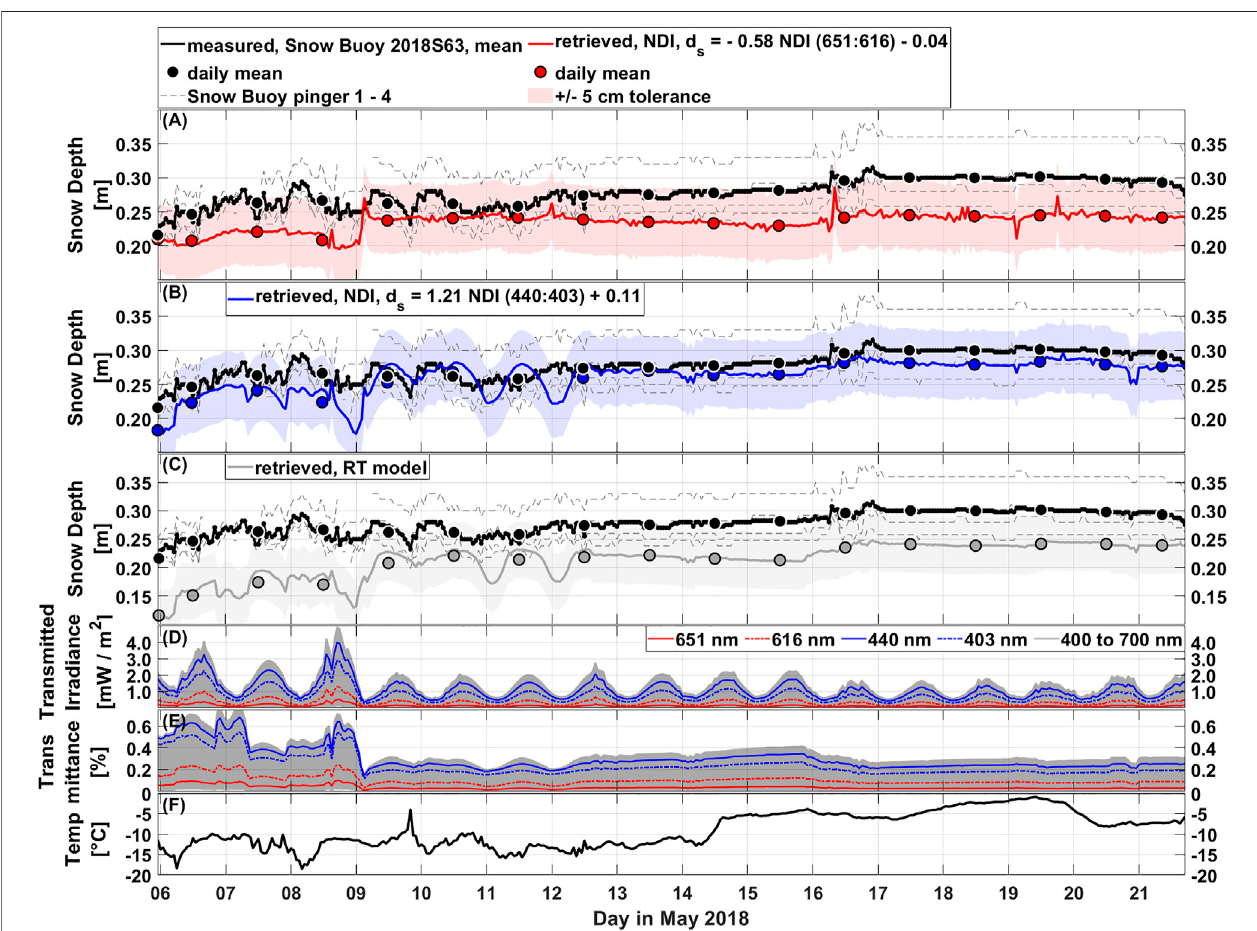
FIGURE7|(A – C) HourlymeansnowdepthsmeasuredbytheSnowBuoy2018S63asobtainedonFYIduringMAPLI18(solidblack).Variationsinthesnowdepth of the four individual ultrasonic snow pingers are indicated by the respective grey dashed lines. The snow depths retrieved using the NDI method with the wavelength pairs651:616 nm[ (A) ,red]and440:403 nm[ (B) ,blue]areoverlaid.TheNDIswerecalculatedfromthe2018R23transmittance. (C) RetrievedsnowdepthsusingtheRT model with the extinction coef fi cients from Figure 5 (grey). Corresponding daily means (circles) are overlaid. The tolerance of ± 5 cm is indicated by the respective colouredshadings. (D) TransmittedirradianceinmWm − 2 and (E) transmittancein%forthewavelengthsoftheNDImethod andintegratedfrom400to700 nmasused in the RT model. (F) Air temperature in ° C as measured by the Snow Buoy.